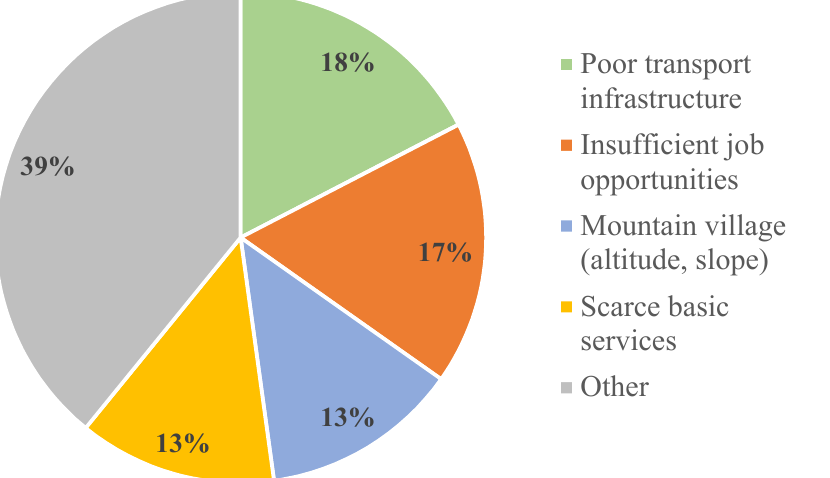
Figure 4. Stated causes for the depopulation figures in the two worst performing protected munici- palities, according to